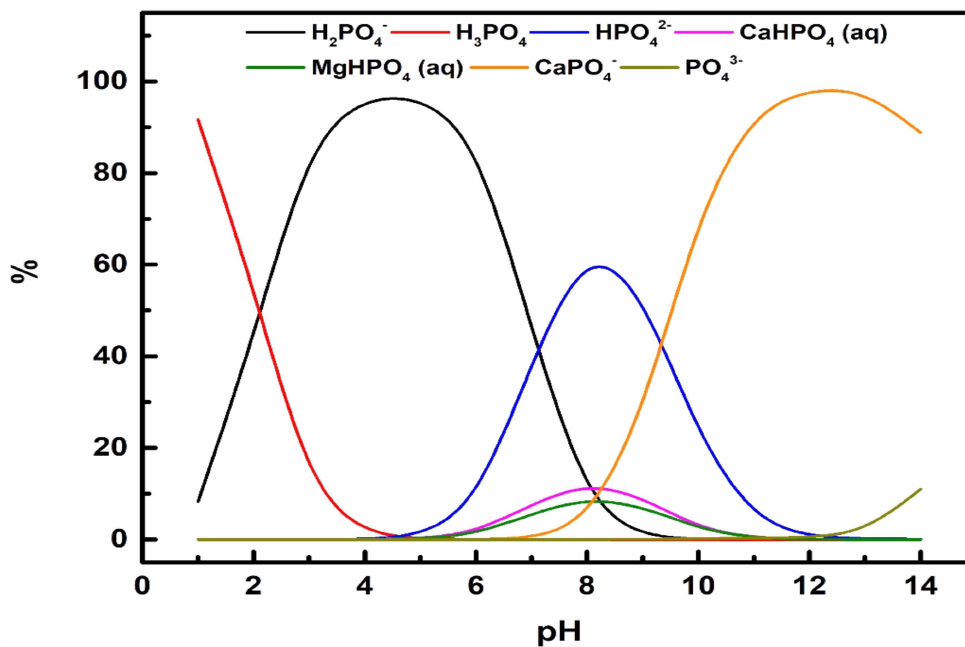
Figure 1. Speciation of the major PO 43 − species using the NSF water matrix at an initial concentration of phosphates of 10 mg/L at 293 K; the respective diagrams were derived by using the Visual